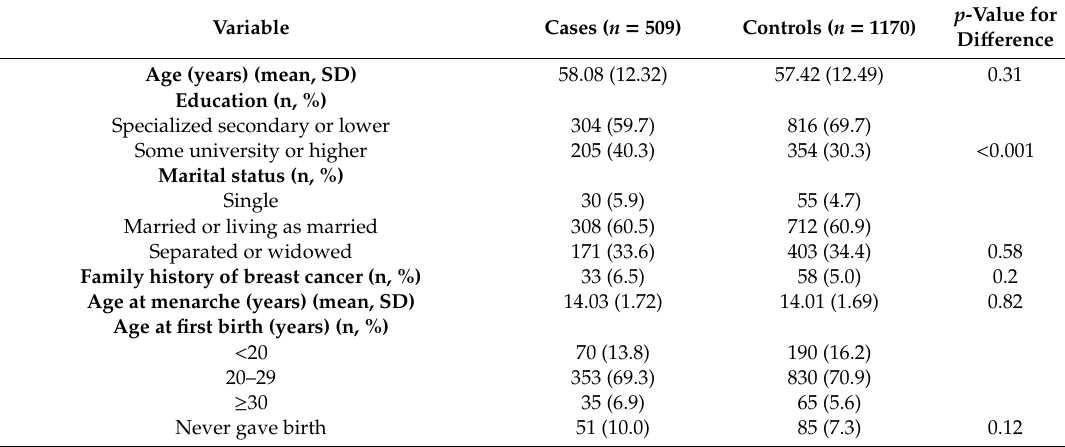
Table 1. Characteristics of invasive breast cancer cases and